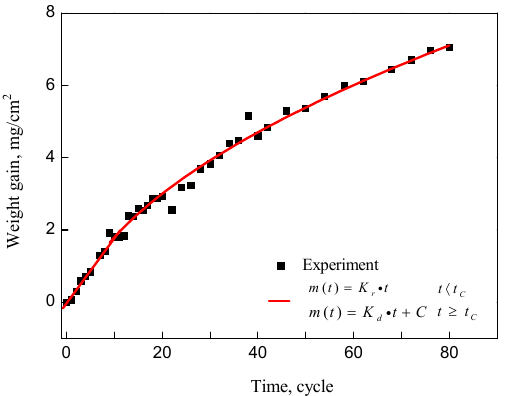
Figure 11. Relationship between calculated and experiment corrosion data. Table 4. Calculated values of K r , K d , and t c for the different oxide scales.